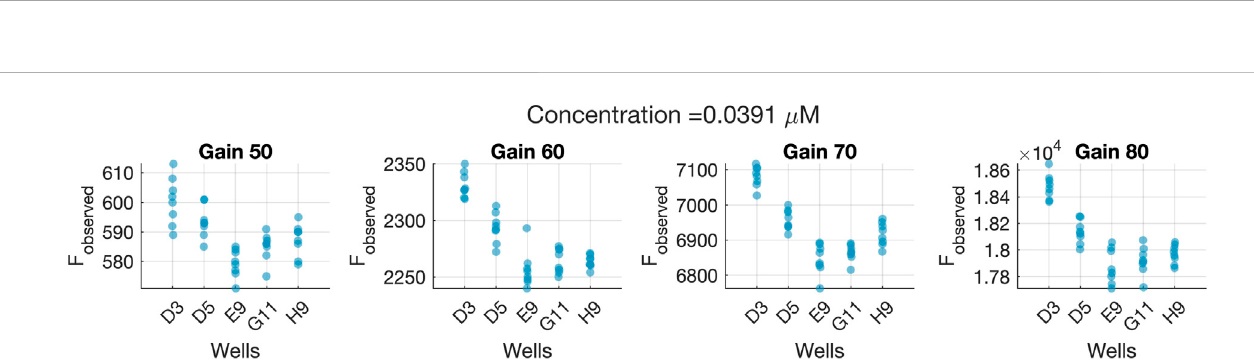
the true concentration. Figure 6 depicts the true concentration values for every data as dashed lines with the con fi dence region (blue shaded area) limited by the extremes of the con fi dence intervals for the predictions. These values were calculated at a 95% con fi dence level ( α = 0.05). Figure 6 shows that the con fi dence intervals for the predictions contain the true concentration value for nearly 95.3125% of the observations in the validation data set.